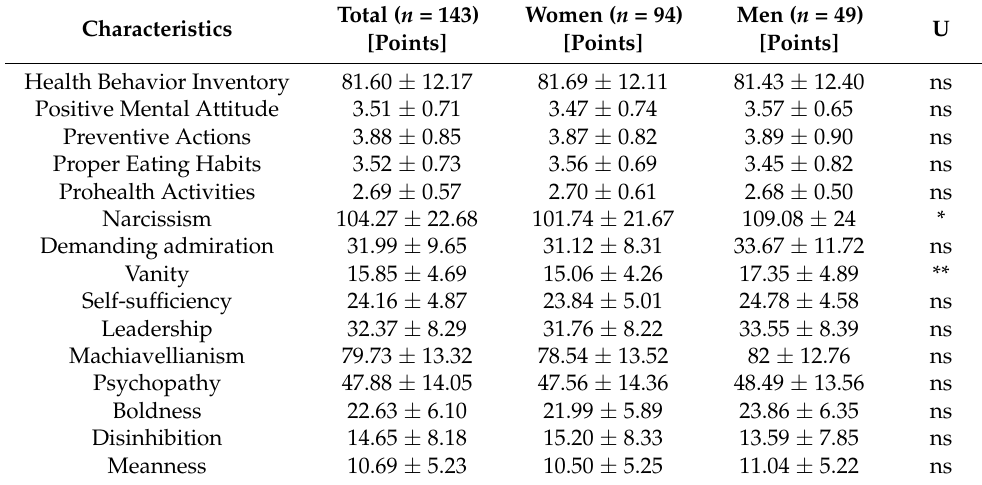
Table 1. The Dark Triad traits and Health Behavior Inventory results.